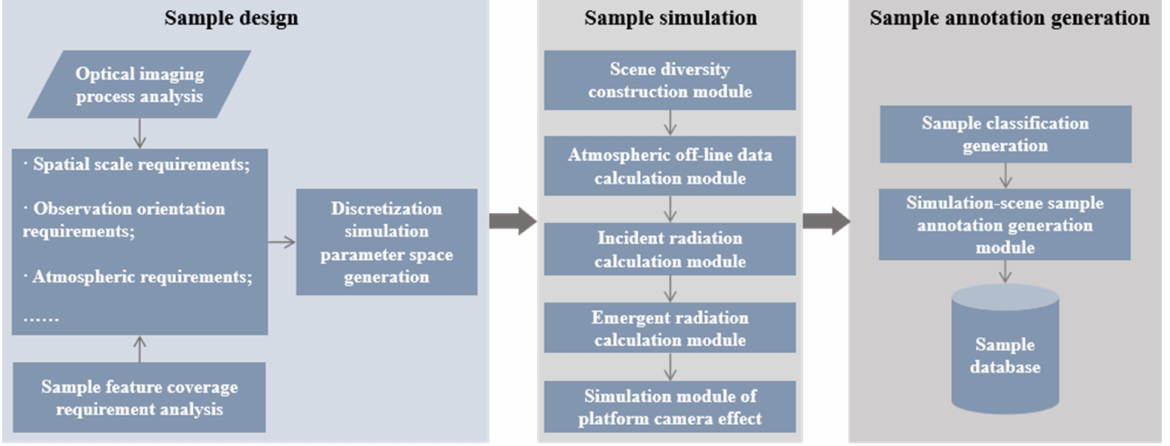
Figure 3. Framework of the visible light imaging simulation